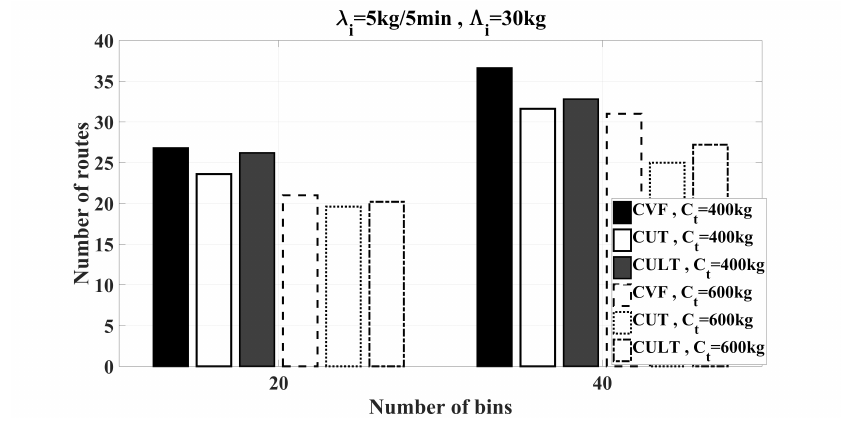
Figure 18. Number of routes: bin count when the bin capacity was increased.